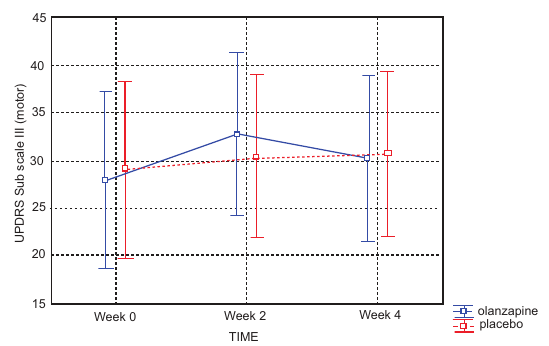
Figure 3. Unified Parkinson’s Disease Rating Scale (UPDRS) scores across four week study revealed no significant difference between placebo and olanzapine groups among study completers. Current effect: F(2, 24)=0.50826, p=0.60787. Effective hypothesis decomposition. Vertical bars denote 0.95 confidence intervals. Olanzipine-blue; placebo-red. Analyses were repeated in like fashion for all other psychiatric and neurological parameters (CGI impression, CGI improvement, BPRS total, BDI, MMSE, insomnia score, hypersomnolence score,